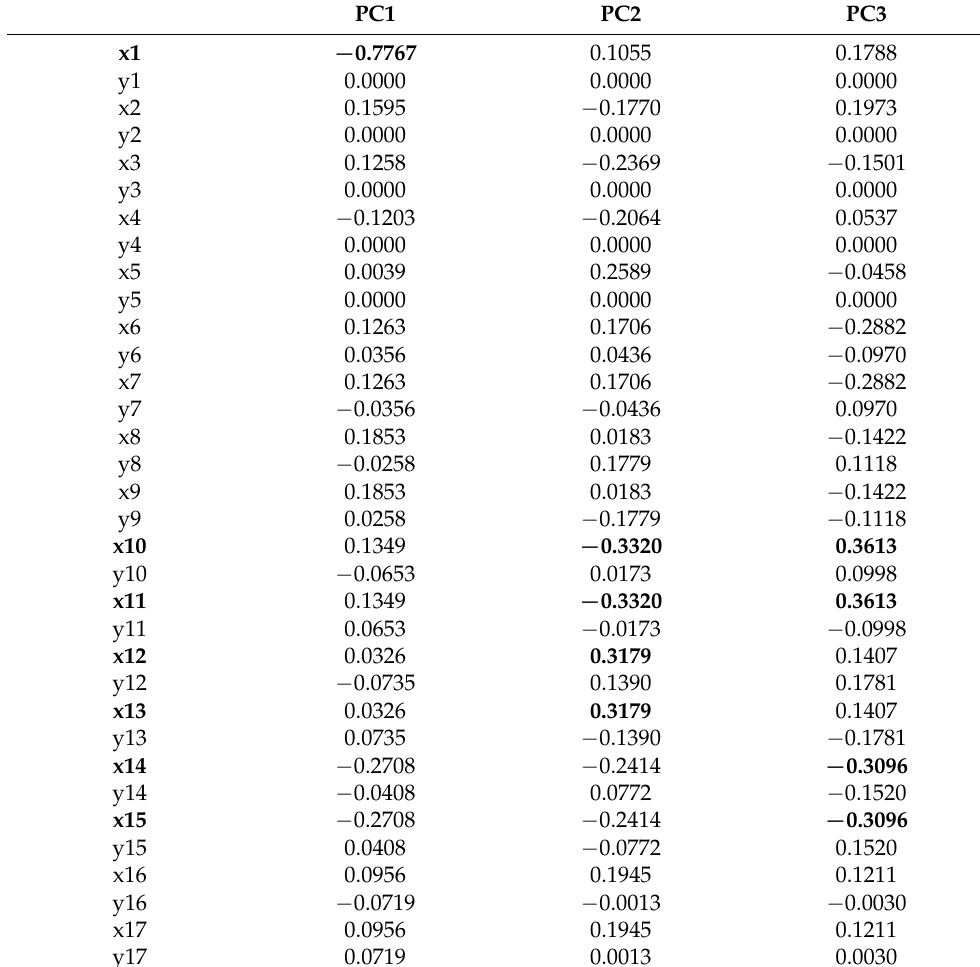
Table 1. Most discriminating coordinates in the Principal Components Analysis for the first three com- ponents (PC1 + CP2 + CP3 = 39.38% + 16.95% + 10.09%). The most discriminative coordinates (>[0.3]) are highlighted in